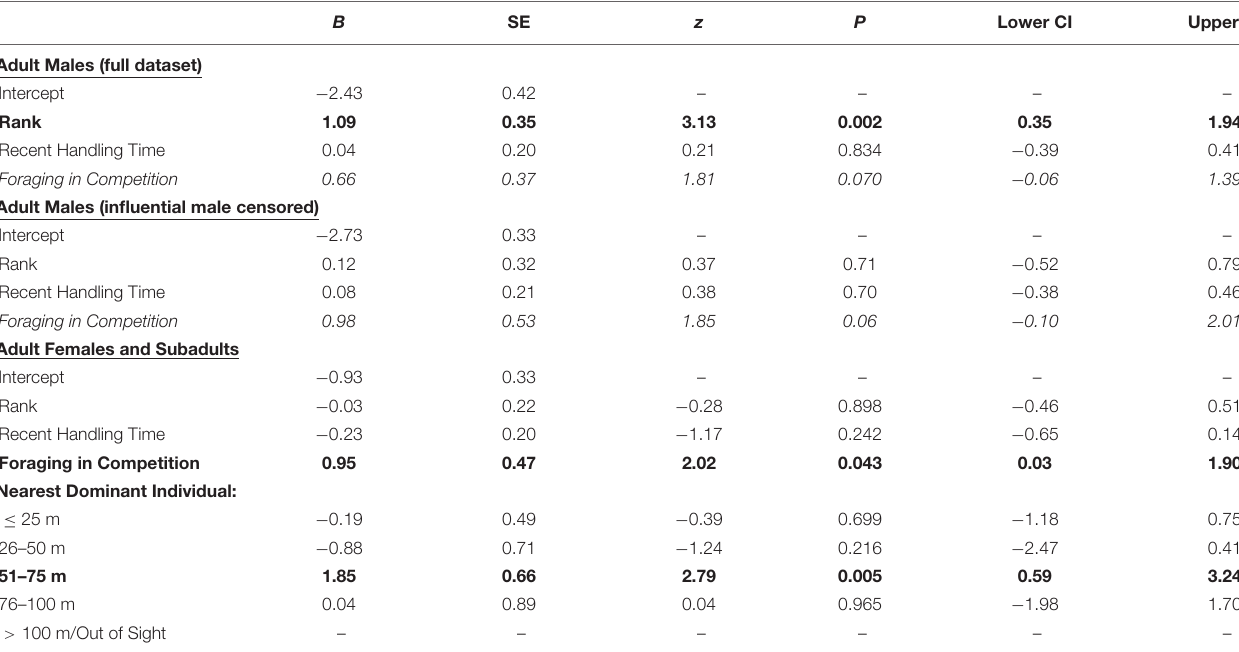
TABLE 2 | In cases where the focal individual had chosen their nearest corn platform in Decision 1, the likelihood that the second platform visited (Decision 2) was the preferred-food/high-handling time one (i.e., a “one corn en route to the banana” strategy) instead of the next corn platform encountered if minimizing travel distance (i.e., a “minimizing travel distance”